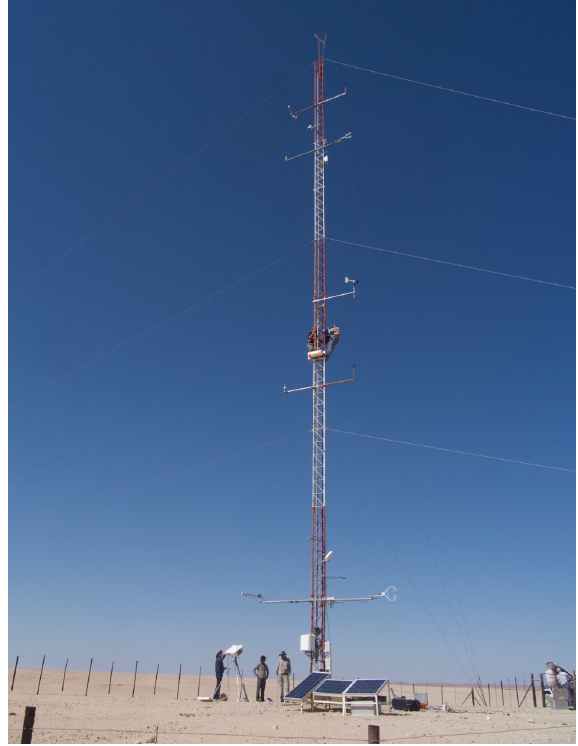
Figure 1. KIT’s permanent validation station GBB Wind on the 16 June